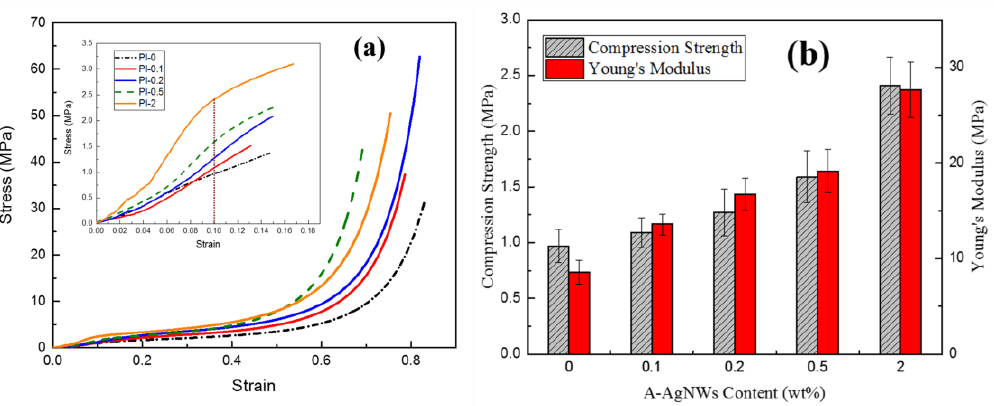
Figure 7. Results of compression tests: ( a ) stress–strain curves of PI-0 to PI-2; ( b ) statistics of compression strength and Young’s modulus of PI-0 to PI-2.